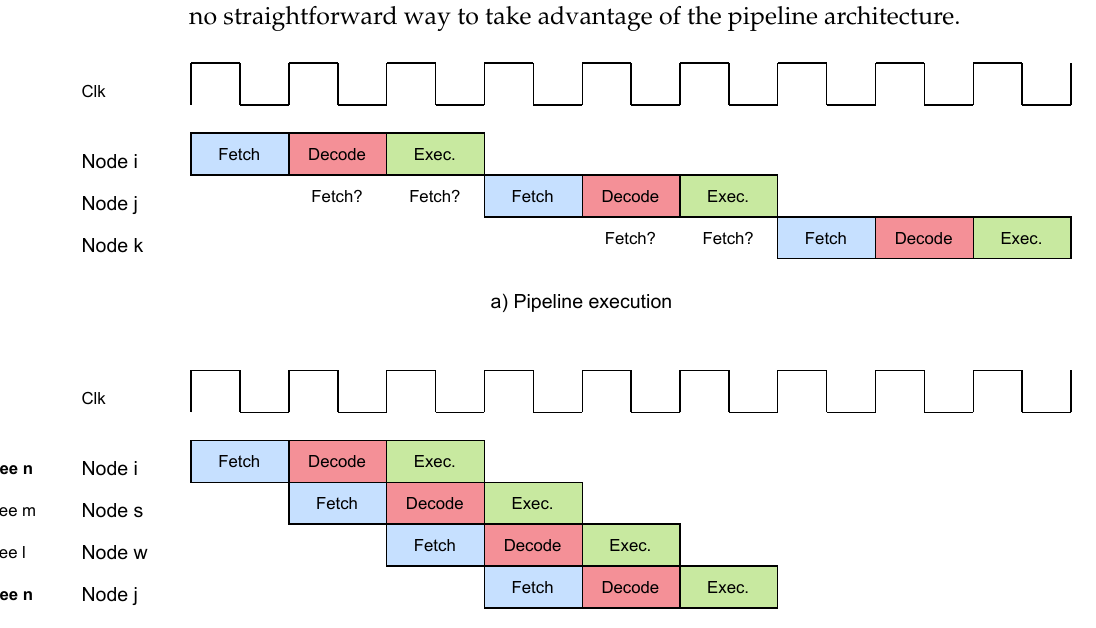
Figure 8. ( a ) Pipeline execution scheme. ( b ) Multi-threaded pipeline execution